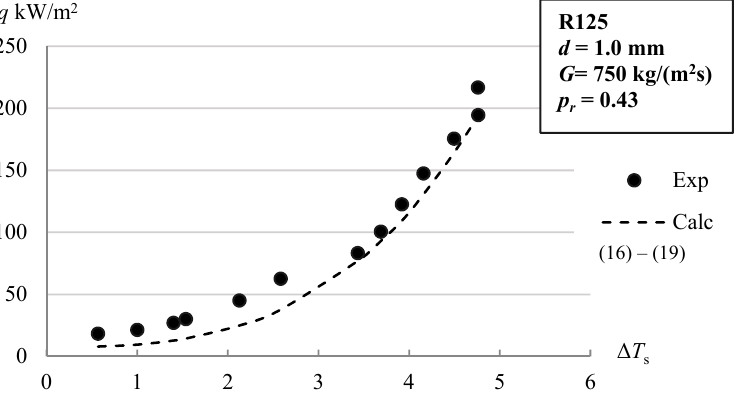
Figure 10. Comparison of the calculated data for heat transfer with the experimental data for saturated liquid ( x local ≈ 0 ÷ − 0.4).